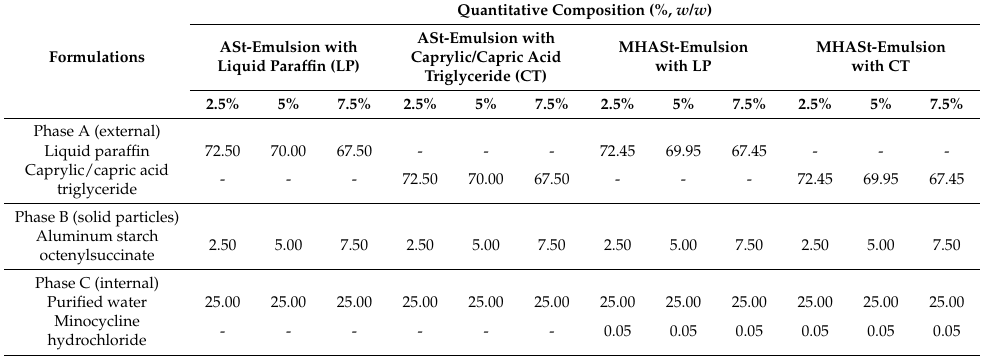
Table 1. Qualitative and quantitative composition of the optimized minocycline hydrochloride (MH)-loaded starch-stabilized pickering emulsions (MHASt-emulsions). Quantitative Composition (%, w / w Formulations